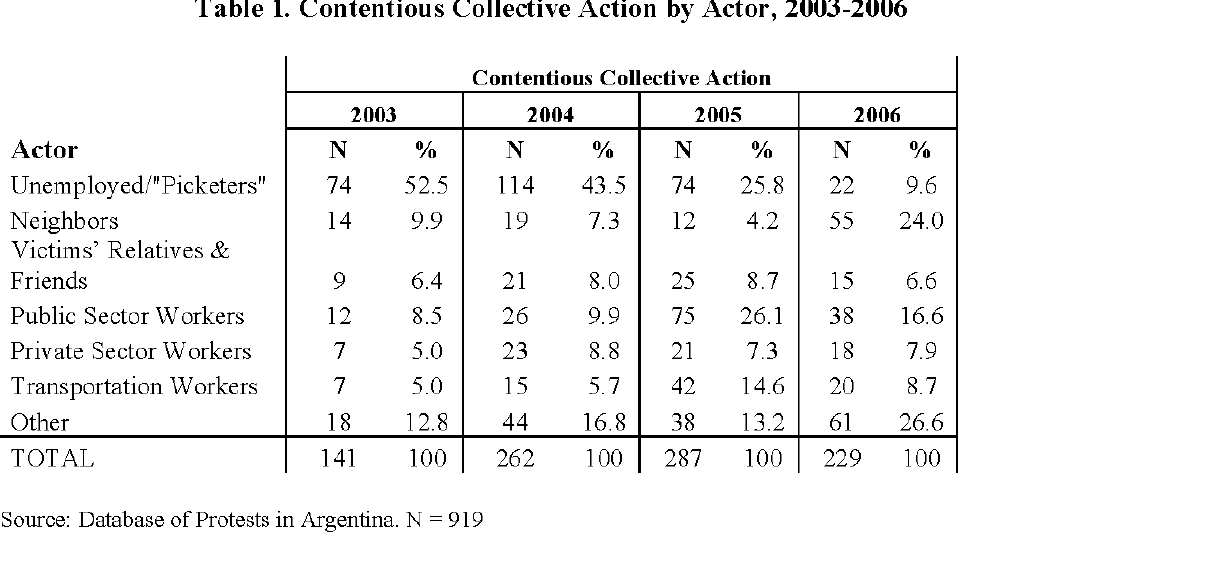
Table 1. Contentious Collective Action by Actor,